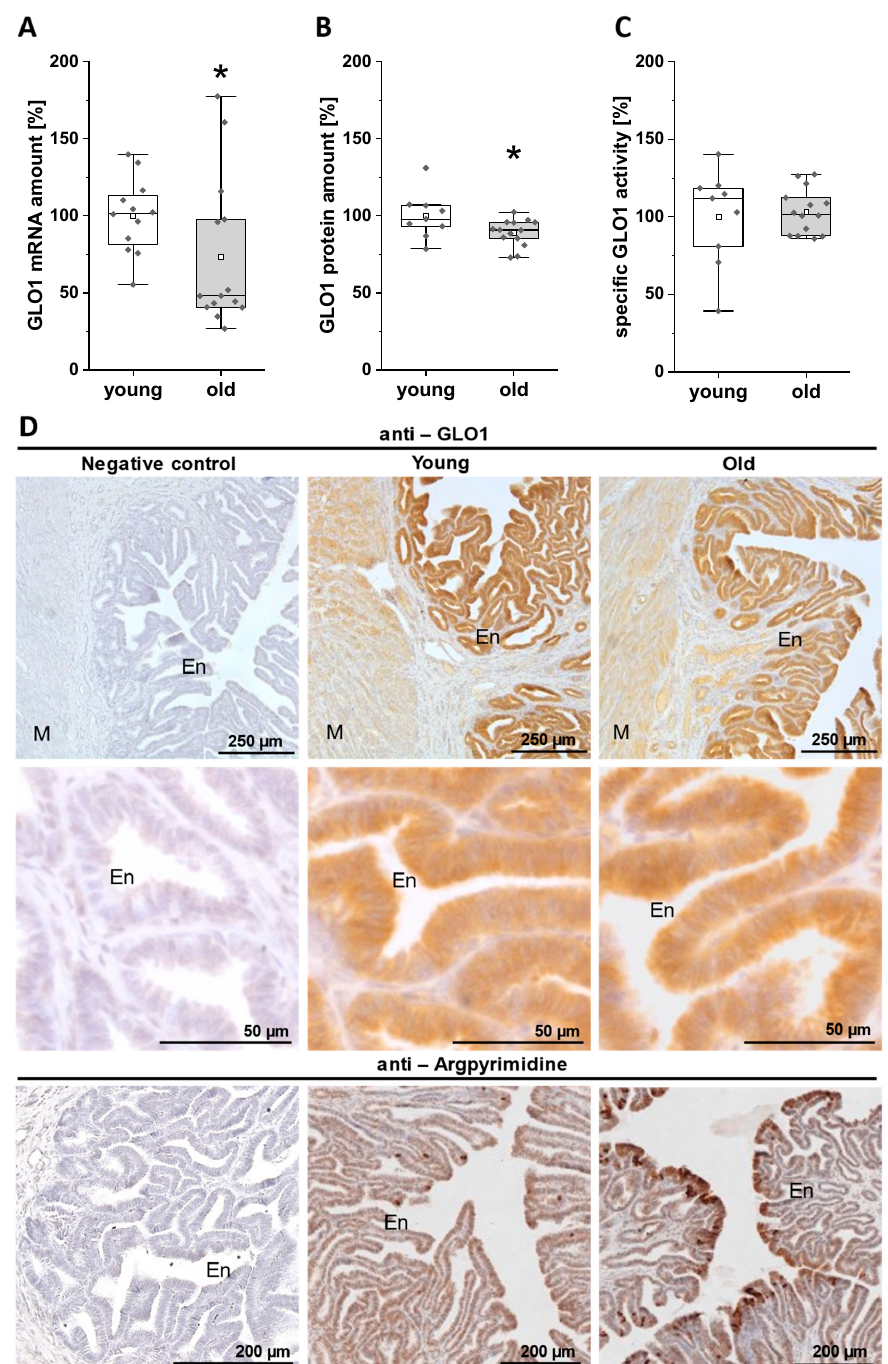
Figure 4. Quantification of GLO1 mRNA, protein and enzymatic activity in the endometrium of young and old rabbits at day 6 p.c. ( A ) GLO1 mRNA levels were quantified by qPCR. The Mann–Whitney U test was used for statistical analysis (* p = 0.033). ( B ) GLO1 protein analysis was carried out by the Simple Western method. Relative mRNA and protein amount are normalised to the levels of vinculin (* p = 0.038). ( C ) Enzymatic GLO1 activity was measured spectrophotometrically in 10 µ g endometrial protein. Specific GLO1 activity was calculated relatively to GLO1 protein amount within the same sample. Results are shown as box plots. All values are expressed in per cent, with young = 100% ( n ≥ 9). ( D ) Immunohistochemical detection of GLO1 and argpyrimidine in cross-sections through the uterine wall. M = Myometrium. En =